Question: Express in one sentence what the figure is showing.
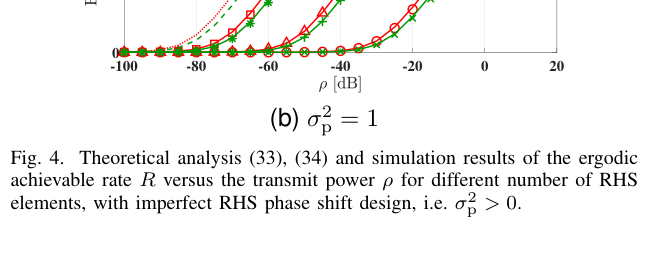
Answer: investigates the effect of HWI of the RF chains at the BSs and the UEs on the ergodic achievable rate. As shown in Fig. 3, the achievable rate is limited by the hardware quality and it saturates in the high transmit power region. Furthermore, it shows that the realistic HWIs cannot be compensated by harnessing more RHS elements. Fig. 4 presents the effect of the PSE of the RHS elements on the ergodic achievable rate, with the phase shift error power of σ2 p = 0.1 and σ2 p = 1. Similar to the effect of the HWIs of the RF chains at the BSs and UEs, the achievable rate cannot be improved without limit in the high transmit power region. Furthermore, Fig. 4 shows that the ergodic achievable rate degrades upon increasing the phase shift error power σ2 p. Then, in the following we focus our attention on the multi- UE case, where K UEs are randomly distributed in the coverage area. Fig. 5 compares the achievable sum-rate R versus the BS density η for different number of UEs, at the tran